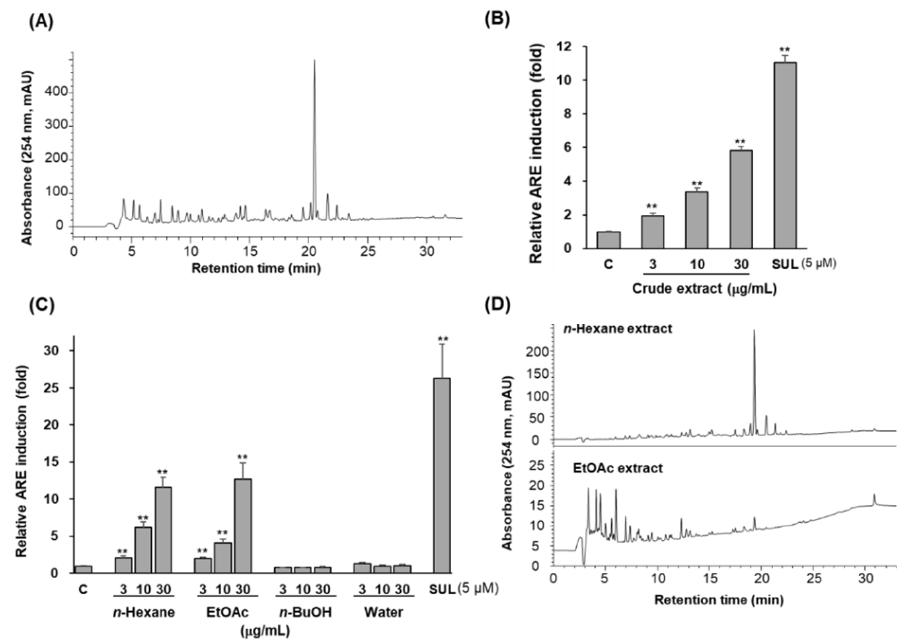
Figure 1. Crude extract of A. oxyphylla induced ARE-luciferase activity in ARE transfected-HepG2 cells. ( A ) HPLC chromatogram of crude extract of A. oxyphylla . ( B ) Relative ARE induction activity of crude extract ( µ g/mL). ( C ) Relative ARE activity of solvent partitioned extracts from crude extract. ( D ) HPLC chromatograms of n -hexane extract and EtOAc extract. Data are presented as the mean ± S.D. ( n = 3). ** p < 0.01 (compared with the vehicle-treated control). SUL: sulforaphane was treated as a positive control.